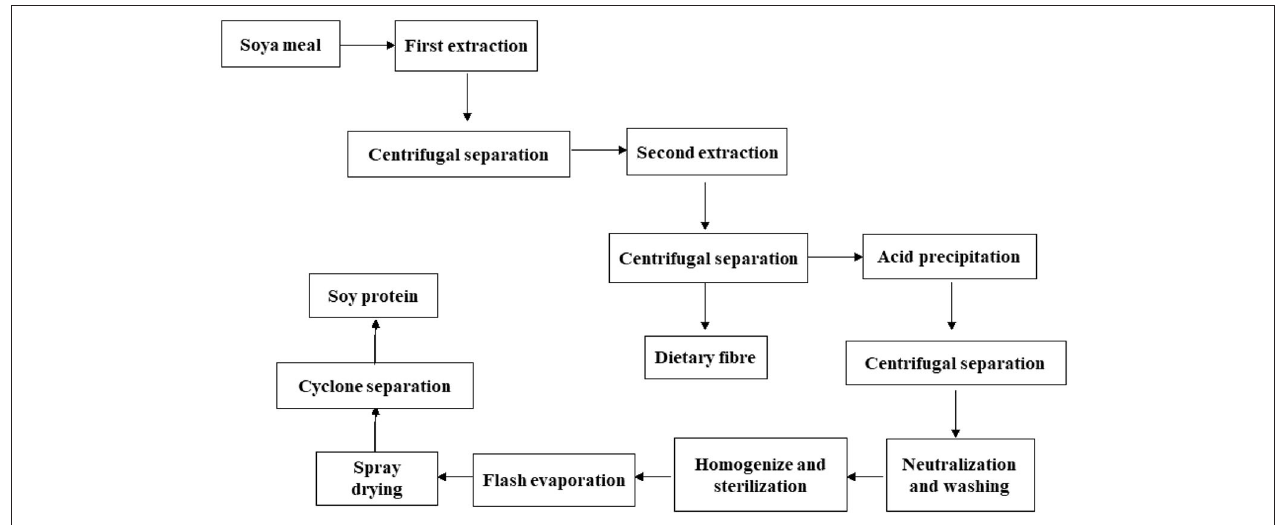
FIGURE 1 | Flow chart of soybean protein extraction